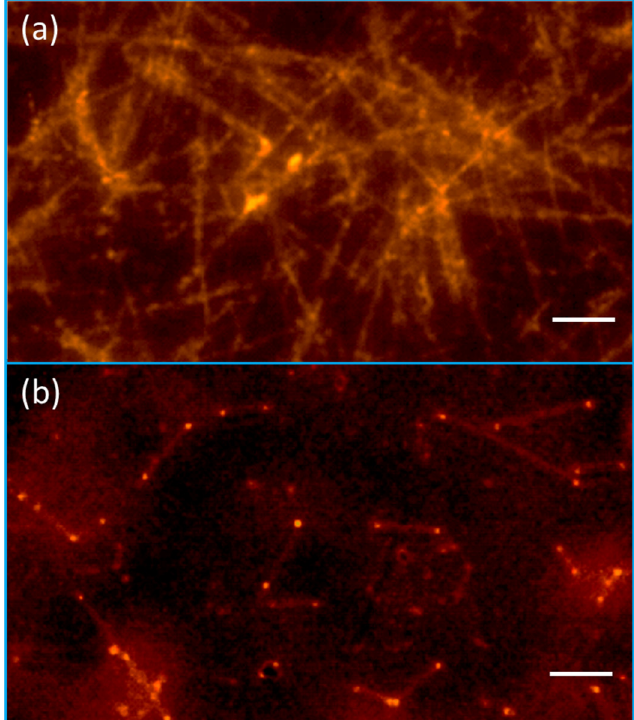
Figure 5. Hot spot distribution for 3D-RCW at the intersection of nanowires ( a ) and at both ends of the nanorods ( b ). The green-light cube was used for this detection of fluorescence microscopy. Scale bar = 10 μ m.